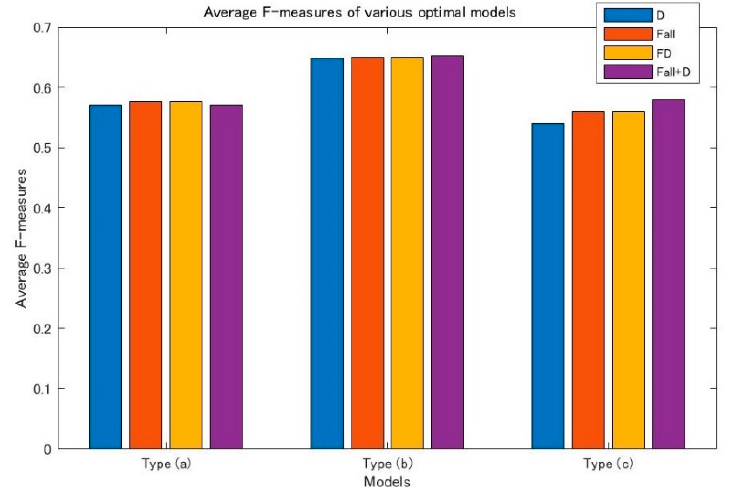
Figure 8. Average F-measures of different optimal models. The values of vertical axis indicate the F-measure’s average values regarding the different optimal models of types a, b, and c. The yellow bar (FD) represents the optimal model determined by Expression (8). The red bar (Fall) and blue bar (D) represent the optimal models determined by Expressions (9) or (10), respectively. It is obvious that the heights of the red bars and yellow bars are the same, but the height of the blue bar is a little low, although it is very close to the yellow bar. The purple bar (Fall + D) represents the optimal model determined by Expression (11). It is observed that the height of the purple bar regarding type a is slightly lower than the yellow bar; that regarding type b is slightly higher than the yellow bars; but, that regarding type c is obviously higher than the yellow bar.